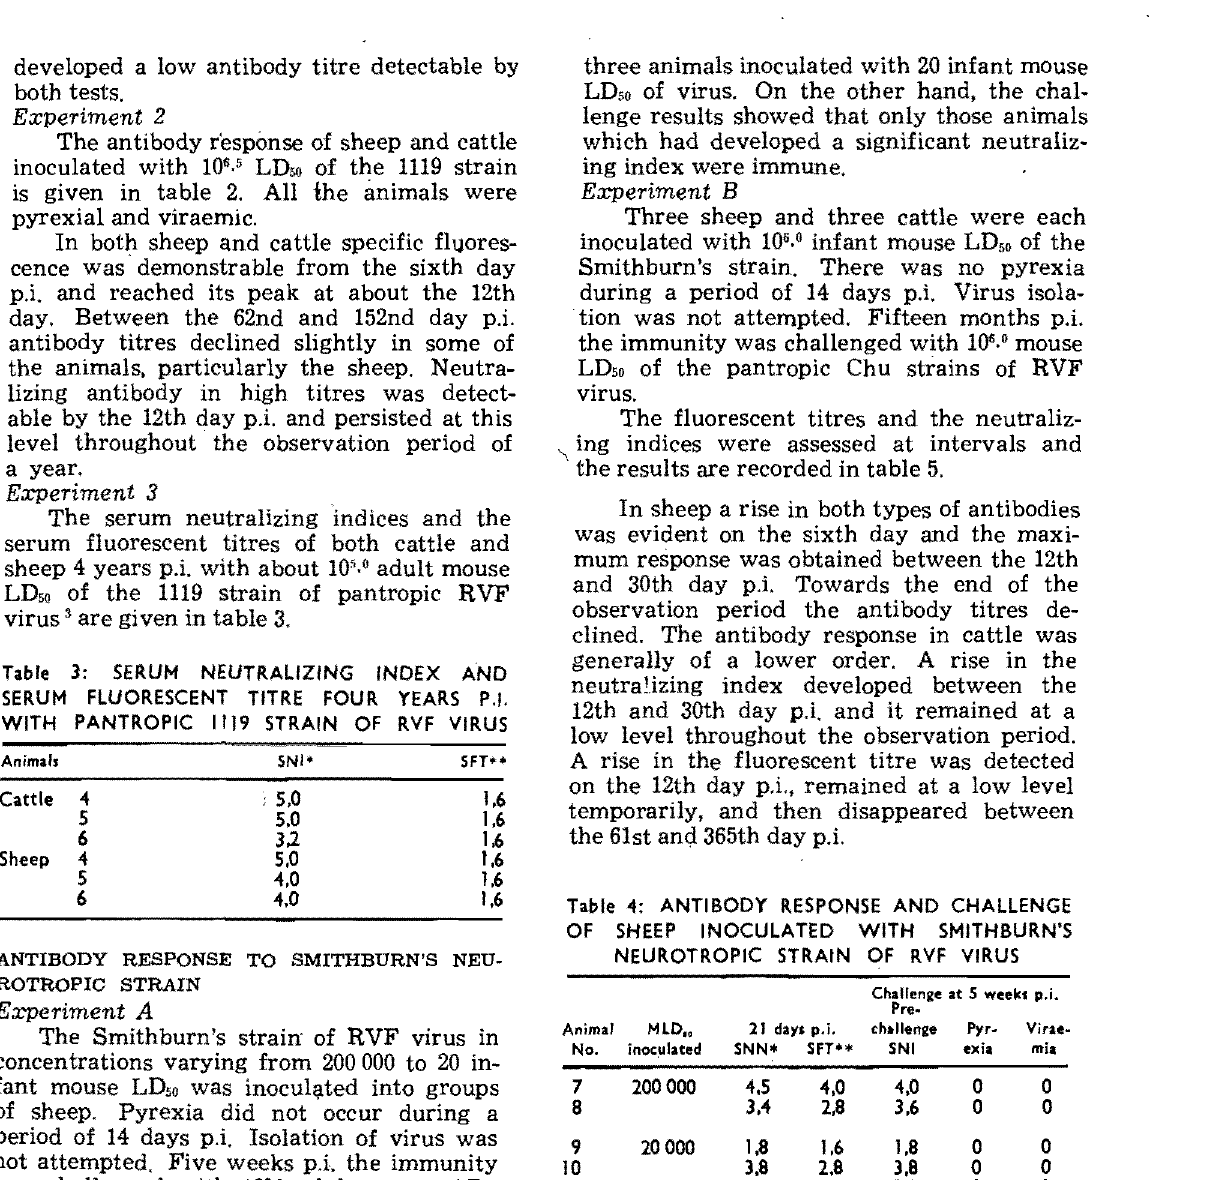
Table 4: ANTIBODY RESPONSE AND CHALLENGE OF